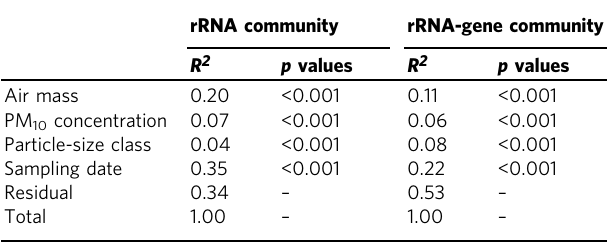
Table 2 The results of PERMANOVA analysis on the terms: air mass, particle concentration, particle size, and sampling date, in this order.